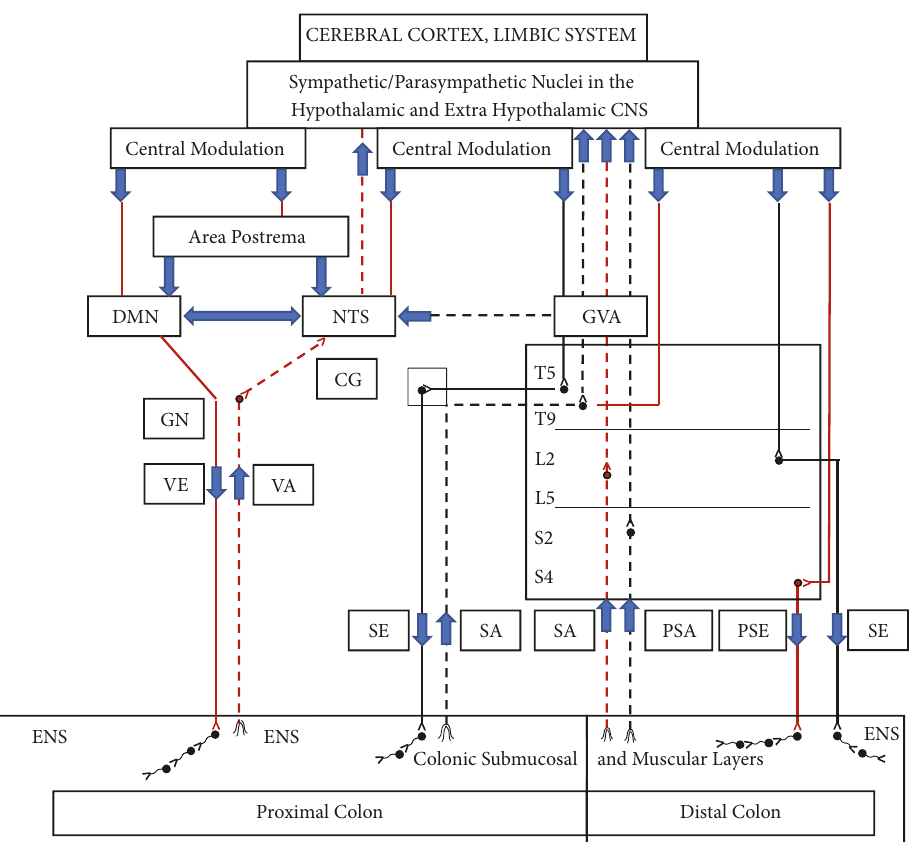
Figure 1: Sympathetic/parasympathetic neurocircuits of proximal and distal colon : DMN (dorsal motor nucleus), ENS (enteric nervous system), GN (ganglion nodosa), GVA (general visceral afferents), NTS (nucleus tractus solitarius), PSA (parasympathetic afferent), PSE (parasympathetic efferent), SA (sympathetic afferent), SE (sympathetic efferent), VA (vagal afferent), and VE (vagal efferent). Proximal colon: vagal efferent fibers (solid red line) travel from the DMN to the submucosal and muscular layers of the proximal colon where they synapse with the multiple neurons and interneurons of the enteric nervous system. Efferent vagal fibers have the two following components: the cholinergic pathway, which has a stimulating effect, and the nonadrenergic noncholinergic pathway, which is inhibitory to colonic motility and secretion. Vagal afferent fibers (dotted red line) originate from the proximal colonic wall and transmit impulses relating to physiological changes (i.e., stretching and distention) to the NTS after synapsing at the GN. The NTS has dense projections that connect to the DMN and area postrema (AP). Impulses from the NTS also projects to higher CNS nuclei for modulation and integration, which provides feedback to the NTS and DMN for stimulation and inhibition. Sympathetic efferent fibers (solid black line) originate from sympathetic nuclei in the thoracic (T5-T9) spinal cord and travel to the proximal colonic wall after synapsing at the celiac ganglion (CG). They induce inhibitory effects except for sphincters. Sympathetic afferent fibers (dotted black line) carry nociceptive information from the proximal colon. After synapsing in the dorsal horn of the spinal cord, they ascend via the spinothalamic tract to reach the NTS directly and via GVAs to reach higher CNS nuclei. Both sympathetic afferent fibers (dotted red line) and parasympathetic afferent fibers (dotted black line) transmit nociceptive impulses from the distal colon via the spinothalamic tract to join GVAs and reach the NTS and higher CNS nuclei. Modulated/integrated information provides feedback to the sympathetic and parasympathetic nuclei in the spinal cord. Distal Colon: parasympathetic efferent fibers (solid red line) originate from parasympathetic nuclei (S2-S4) and travel to the distal colon to induce stimulating effects except for sphincters. Sympathetic efferent fibers (solid black line) originate from sympathetic nuclei (L2-L5) and travel to the colonic wall after synapsing at the IMG to induce inhibitory effects except for